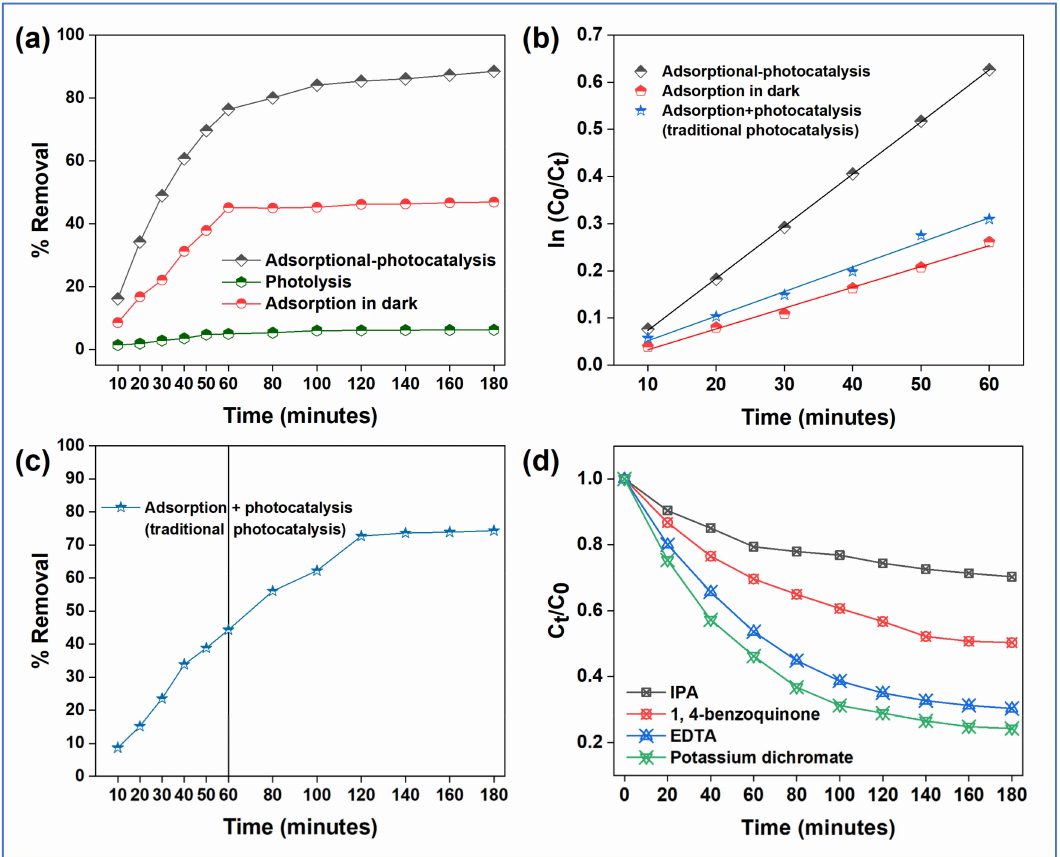
Figure 5. Remediation of CV ( a ) adsorption-coupled-photocatalysis, adsorption in dark and photoly-